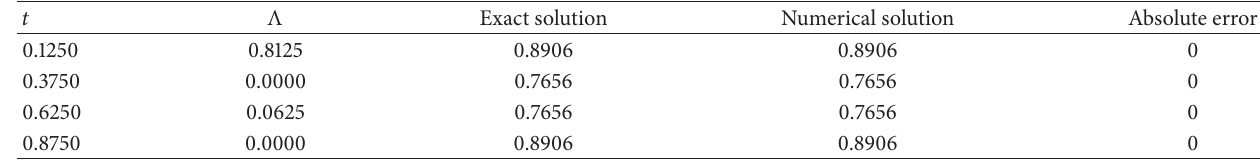
Table 4: Computational results of Example 2 for 𝑅 = 1 and 𝑛 = 3 .